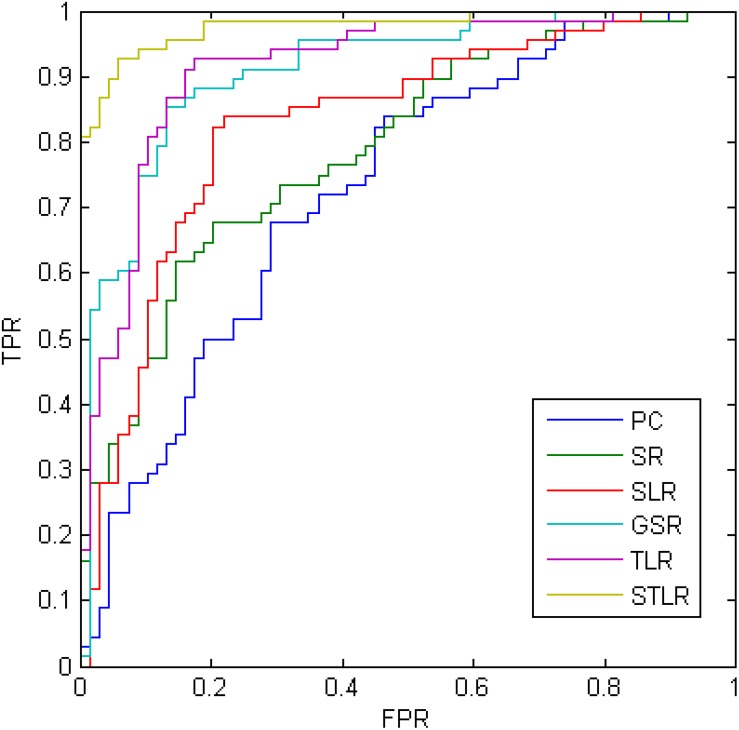
The ROC results of different methods.